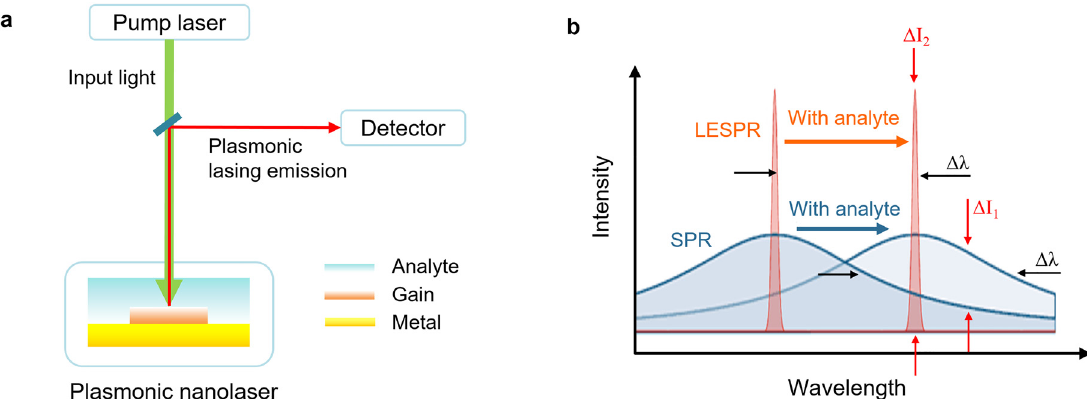
Figure 6: Lasing enhanced surface plasmon resonance (LESPR) sensor. a Measurement scheme. A plasmonic nanolaser is surrounded by the liquid analyte. The refractive index change of the analyte modi fi es the cavityresonanceconditionandthusthelasingwavelength.DuetothecoherencenatureofthelasingemissionthesignalfromaLESPRsensor has a much narrower linewidth comparing to the SPR sensor. b A schematic showing that, for a given resonance peak shift, a resonance with narrower linewidth will have larger intensity change. Figure adapted